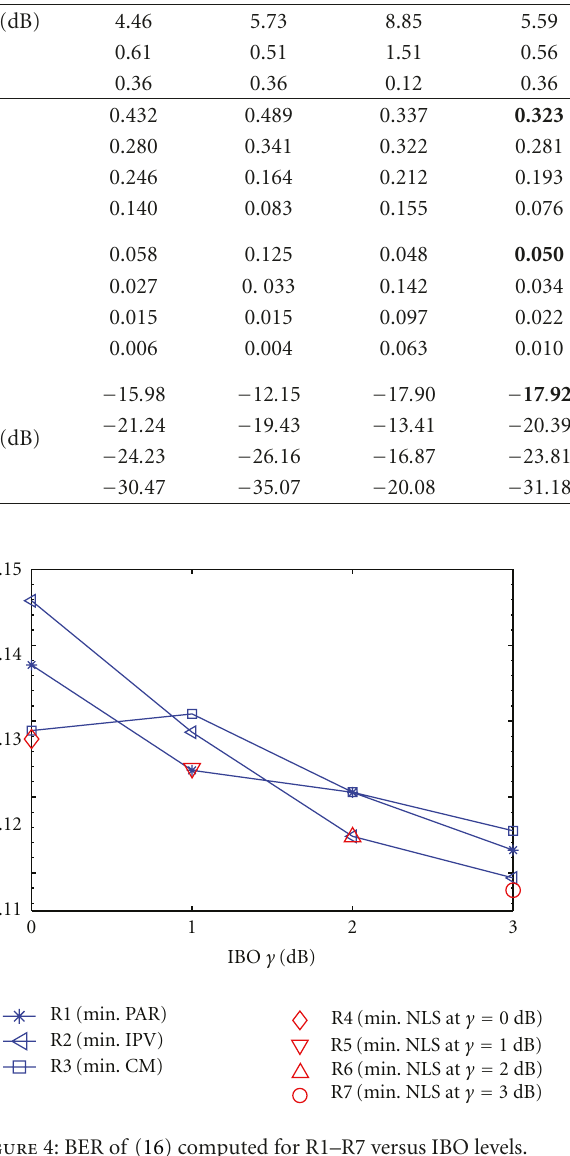
representations R4, R5, R6, and R7, which are selected such that they have a minimal NLS at IBO = 0, 1, 2, and 3 dB, respectively. The NLS measure is measured for all representations and shown along with the other parameters of interest in Table